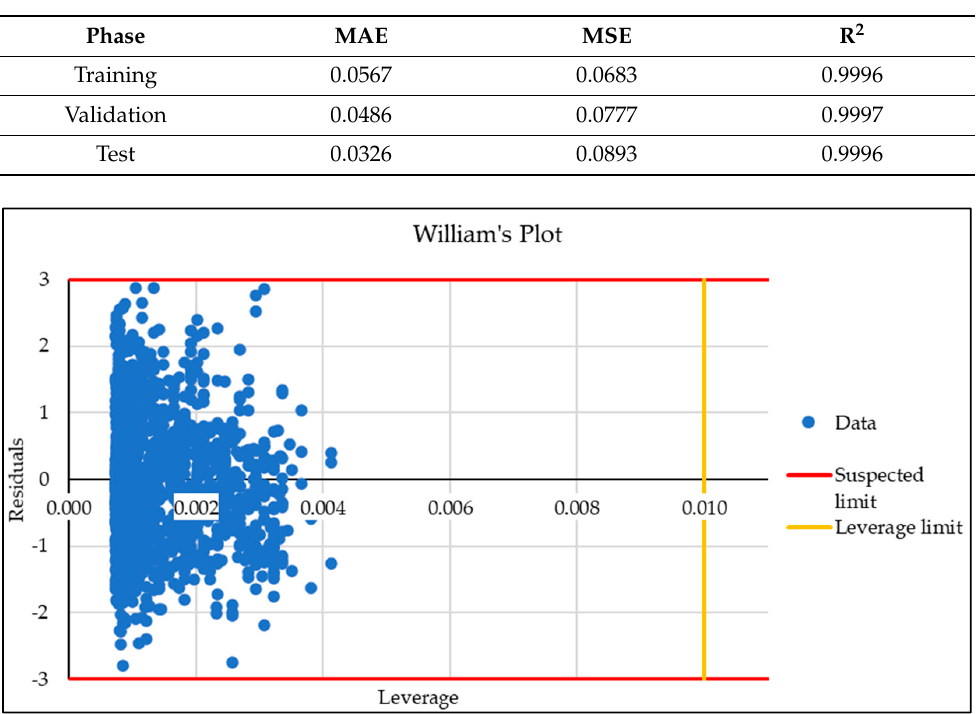
Table 9. Mean absolute error (MAE), MSE, and R 2 values of the model for training, validation, and test phase.